Question: Which visualization type does this figure use?
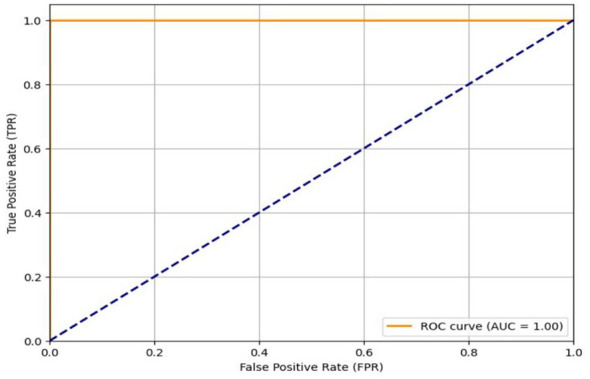
Answer: line